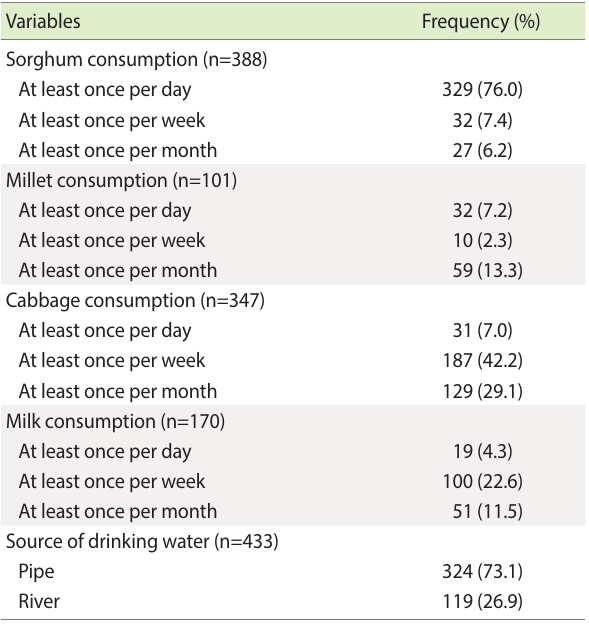
Table 2. Dietary habit and goitrogenic food consumption of children aged 7-12 years in Gasgibla woreda , Waghimra Zone, northeast Ethi-